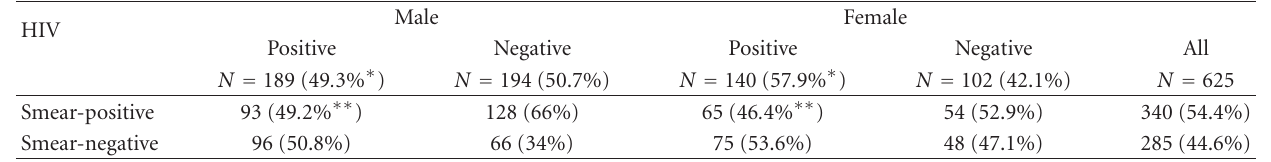
Table 2: Smear-microscopy results by HIV status and gender in culture-positive patients. HIV